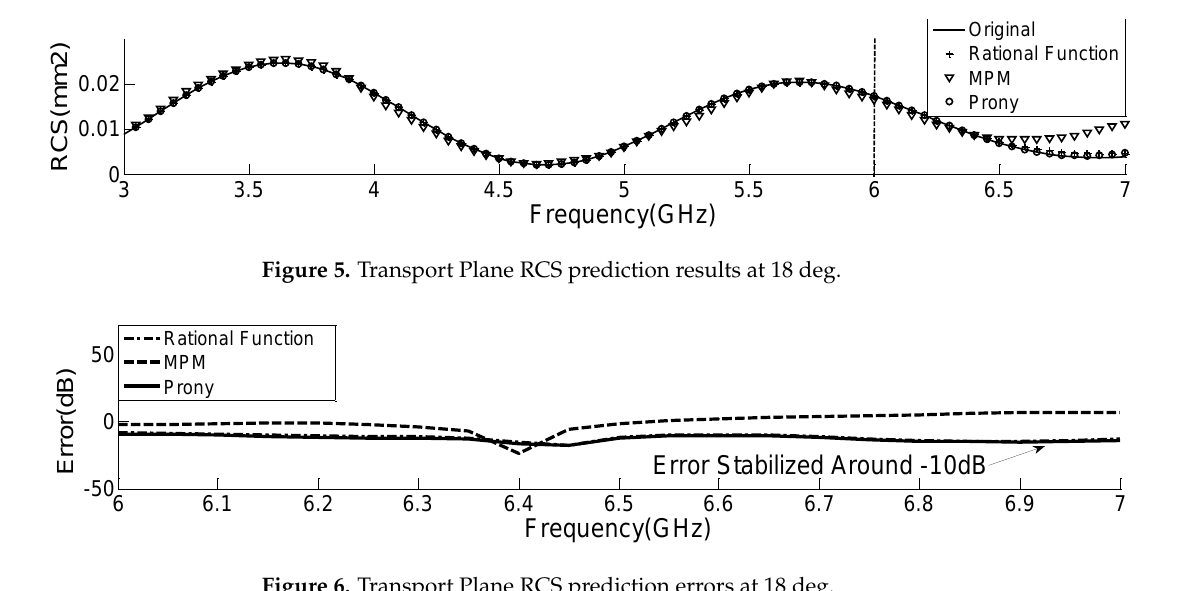
Figure 5. Transport Plane RCS prediction results at 18 deg. Figure 4. Jet Plane RCS prediction errors at 21 deg.